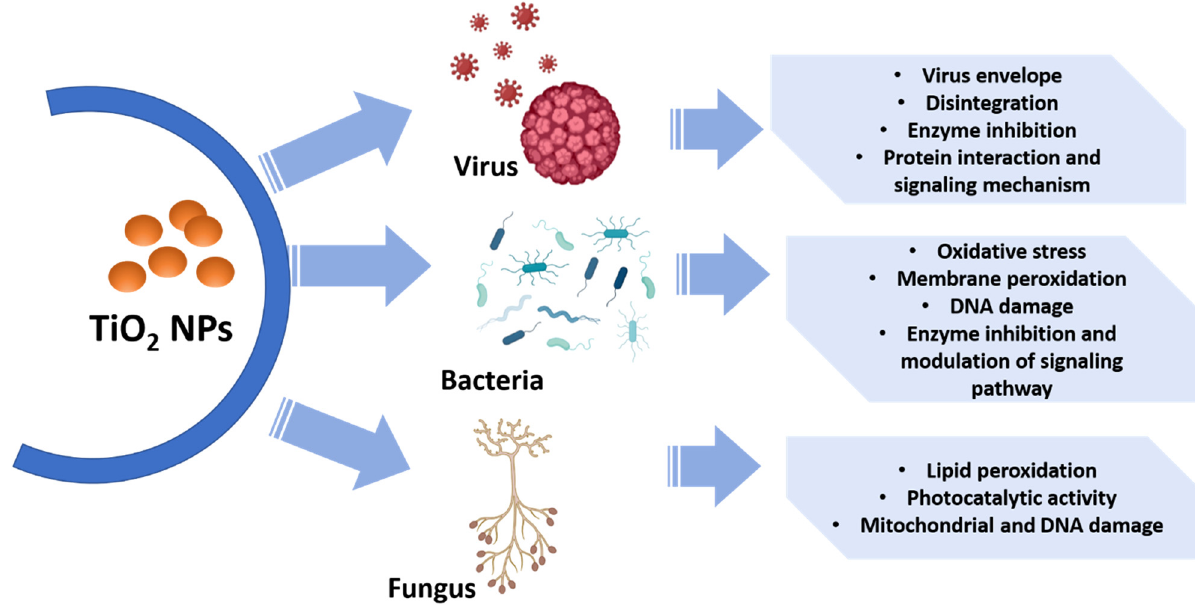
Figure 8: Approaches through which TiO 2 - NPs induce antiviral, antibacterial, and antifungal